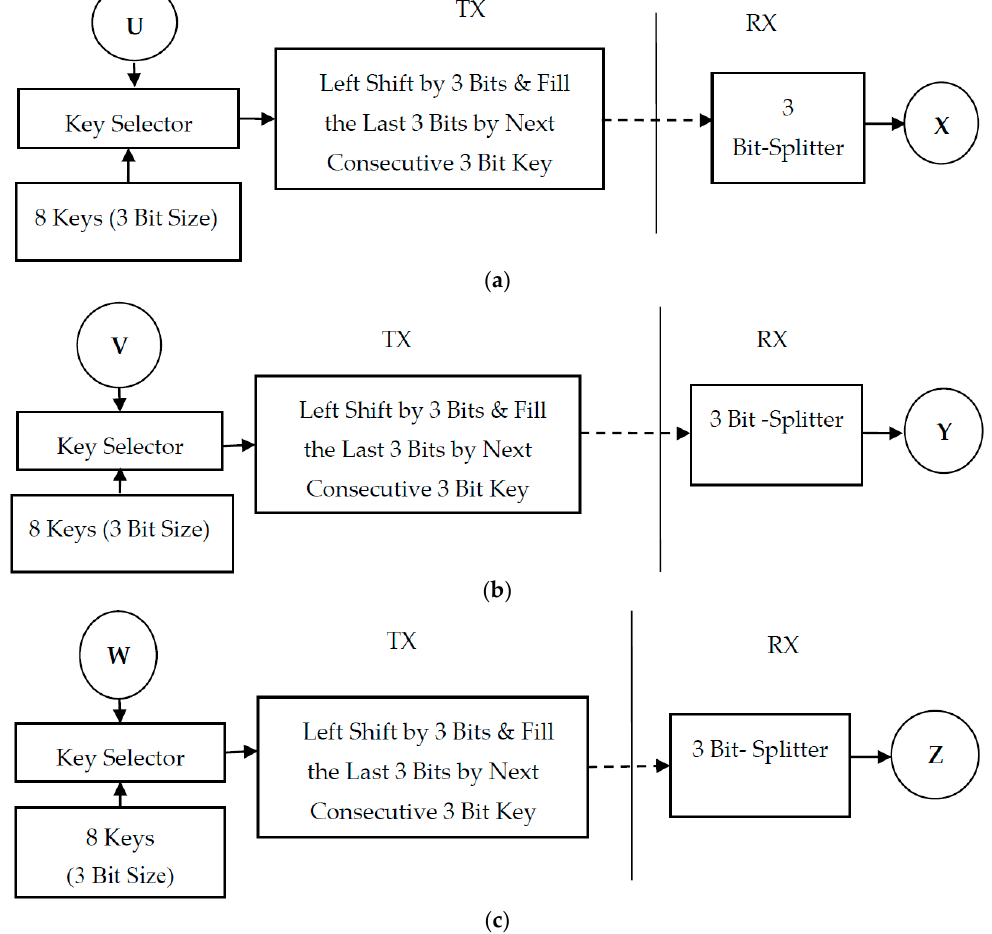
Figure 6. Key generation and reception ( a ) Red plane, ( b ) Blue Plane, ( c ) Green Plane.